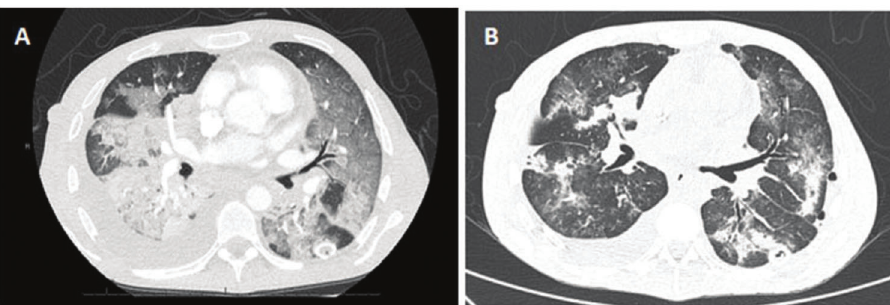
Figure 1 - A) Chest computed tomography (CT) on post-operative day (POD) 12, one day before COVID-19 diagnosis, marked by bilateral alveolar opacities characterized as consolidation and ground-glass opacity areas covering more than 75% of the lungs B) Chest CT on POD 25 showing bilateral consolidation and ground-glass opacity areas under high